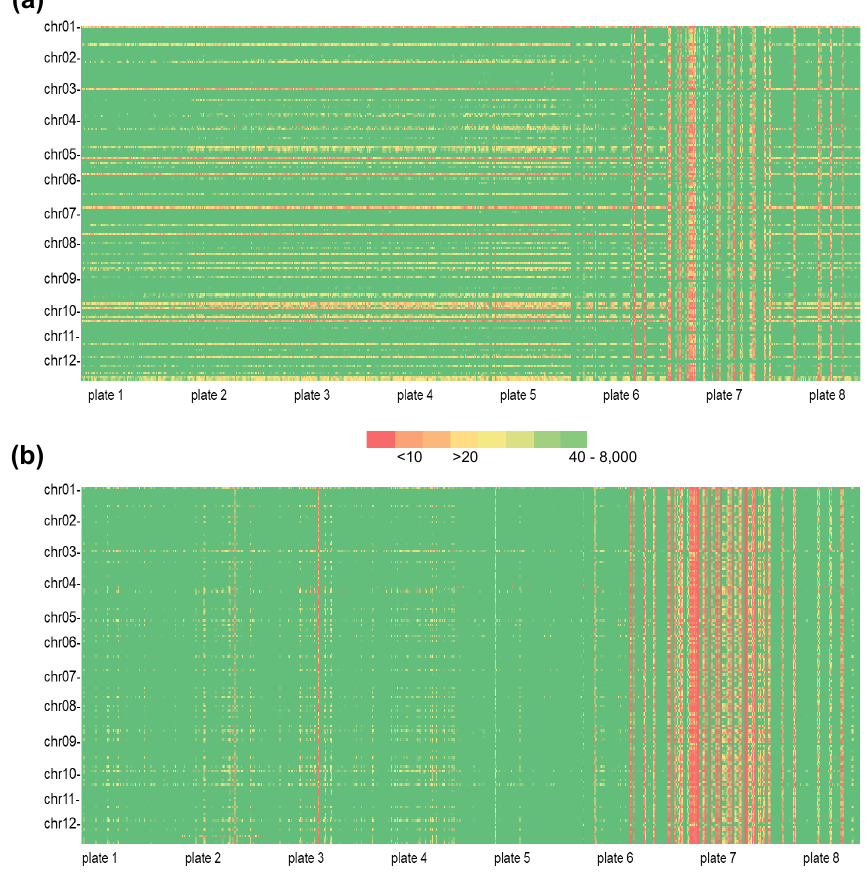
Figure 5. Coverage of the 339 PotatoMASH core loci. Heat map of the number of merged and filtered reads of 765 samples (in columns) that mapped to each locus (in rows). ( a ) Normalized library ( b ) Non-normalized